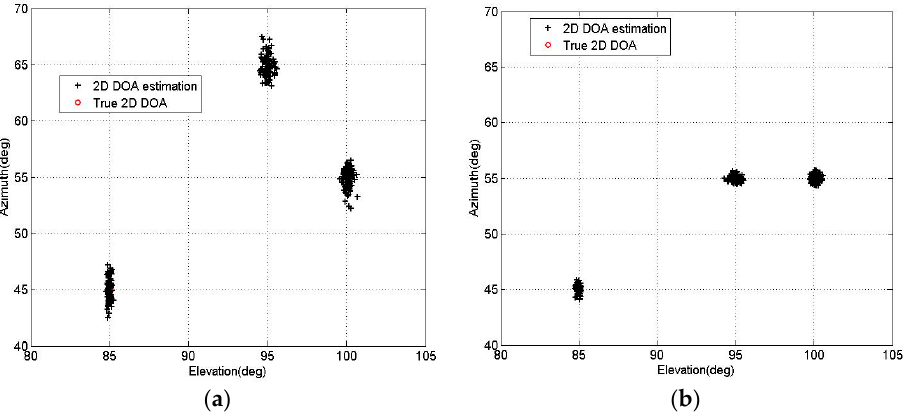
Figure 5. 2D DOA estimation results of PM-AMM algorithm. ( a ) Three signals with different elevation and azimuth angles; ( b ) Two signals with the same azimuth angles.